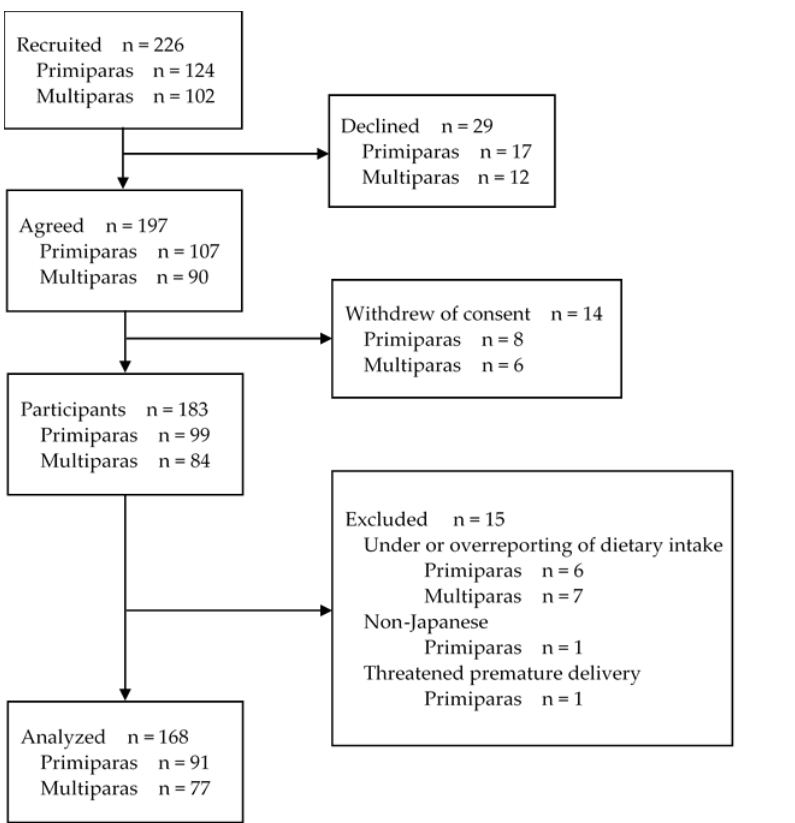
Figure 1. Flowchart of the participants. Table 1. The characteristics of primipara participants.